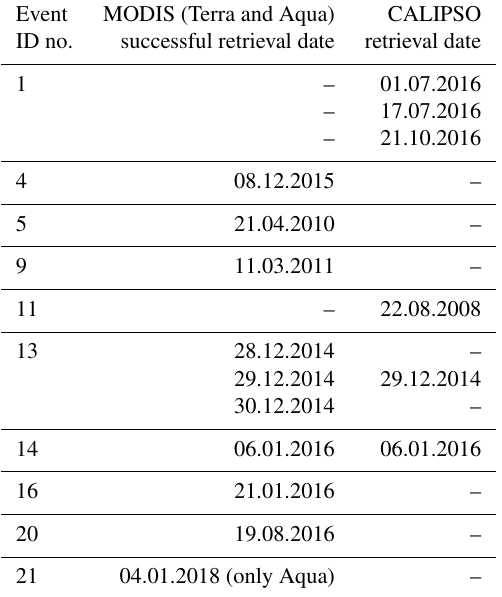
Table 2. List of successful MODIS retrievals and CALIPSO over- pass